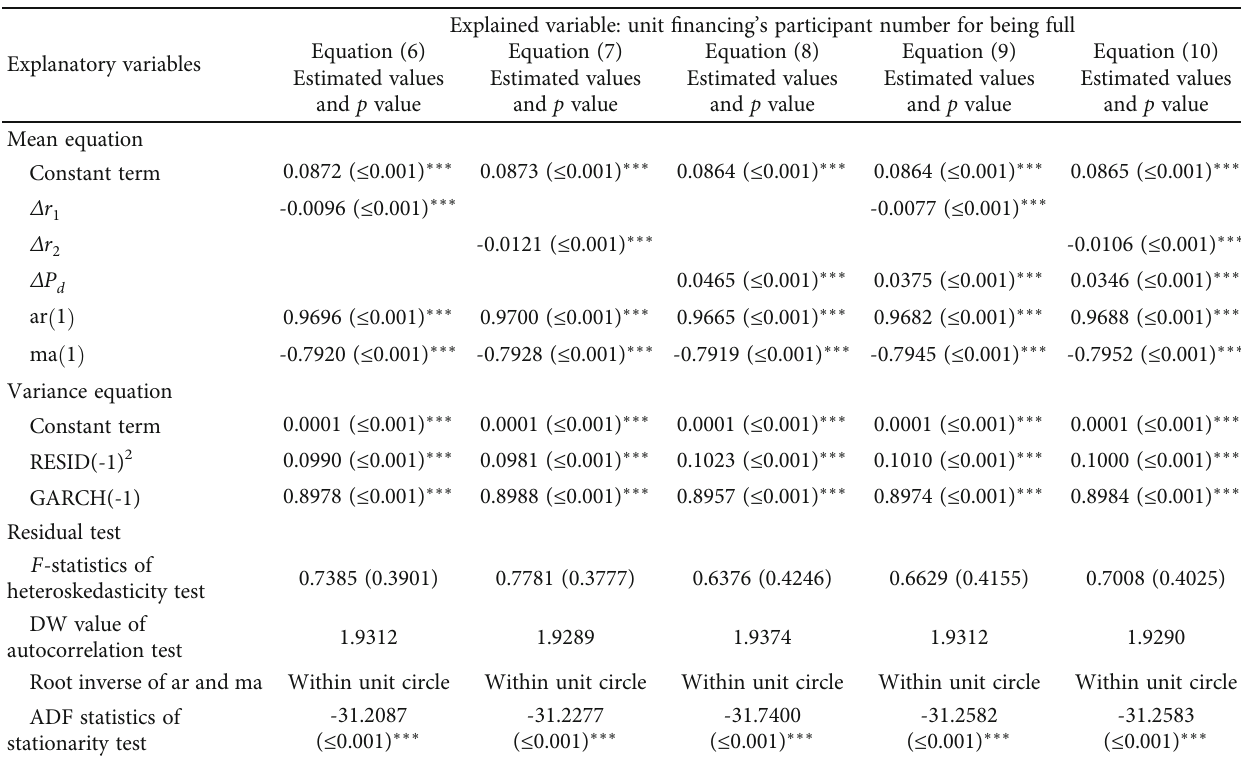
Table 7: Regression results to participant number for being